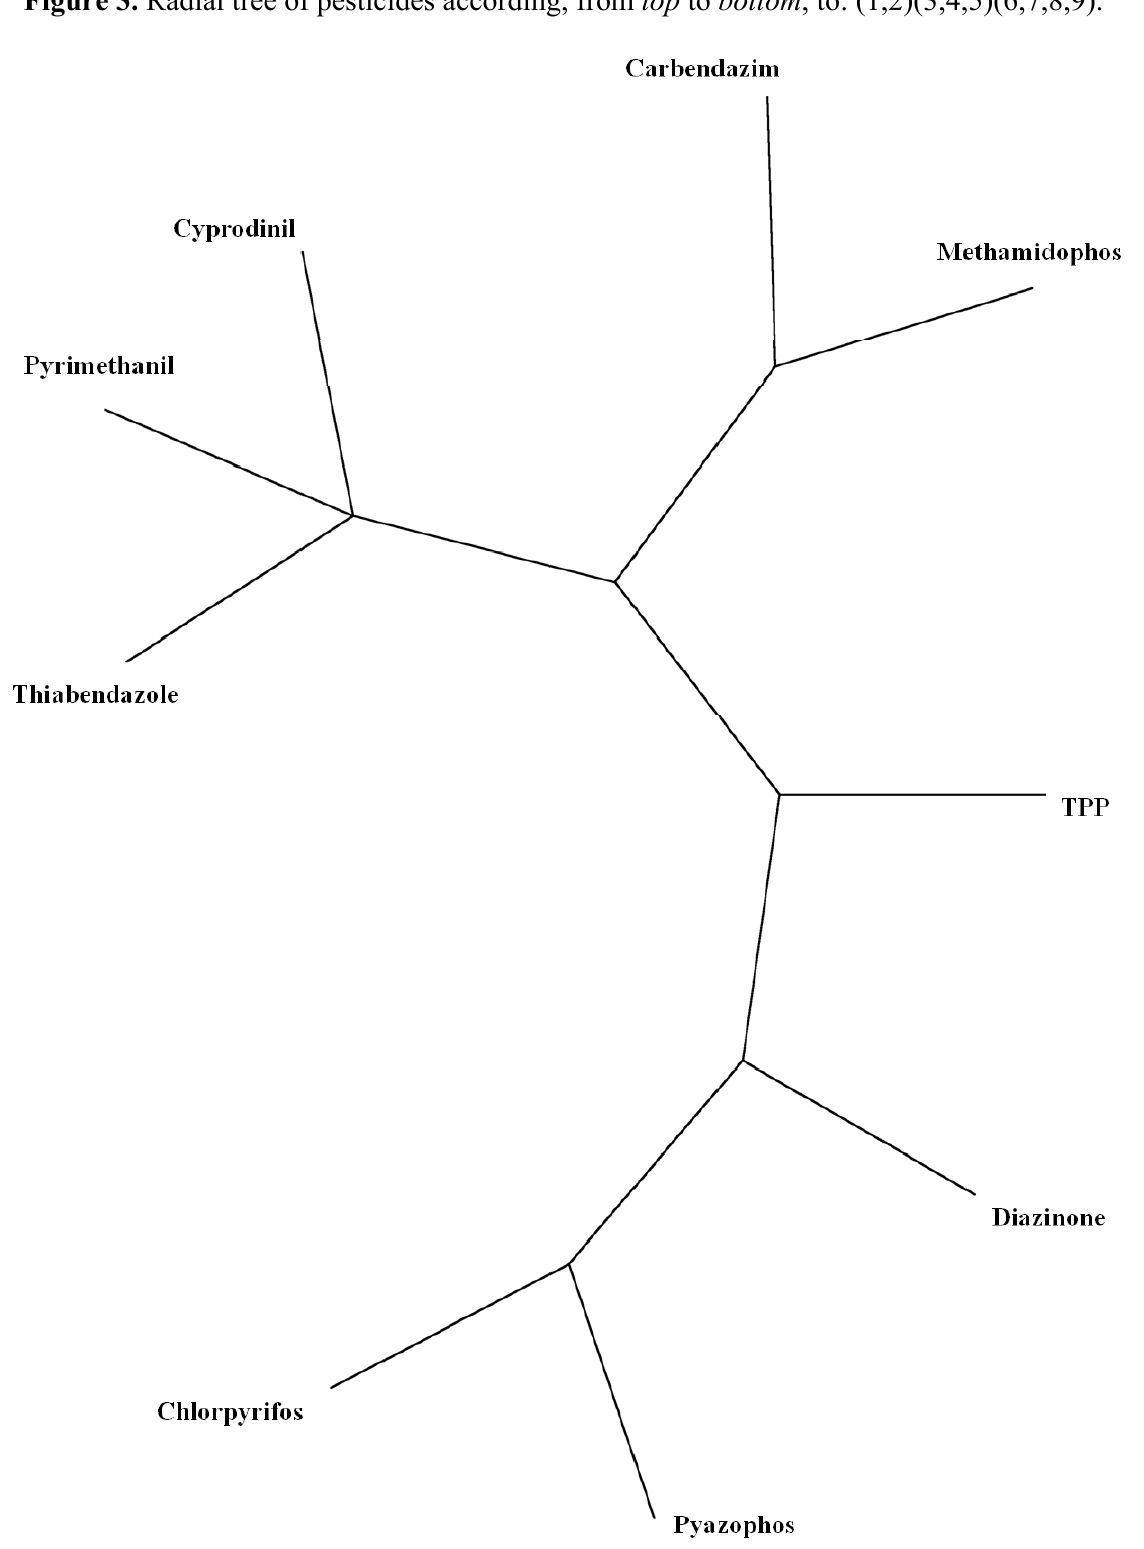
Figure 3. Radial tree of pesticides according, from top to bottom , to: